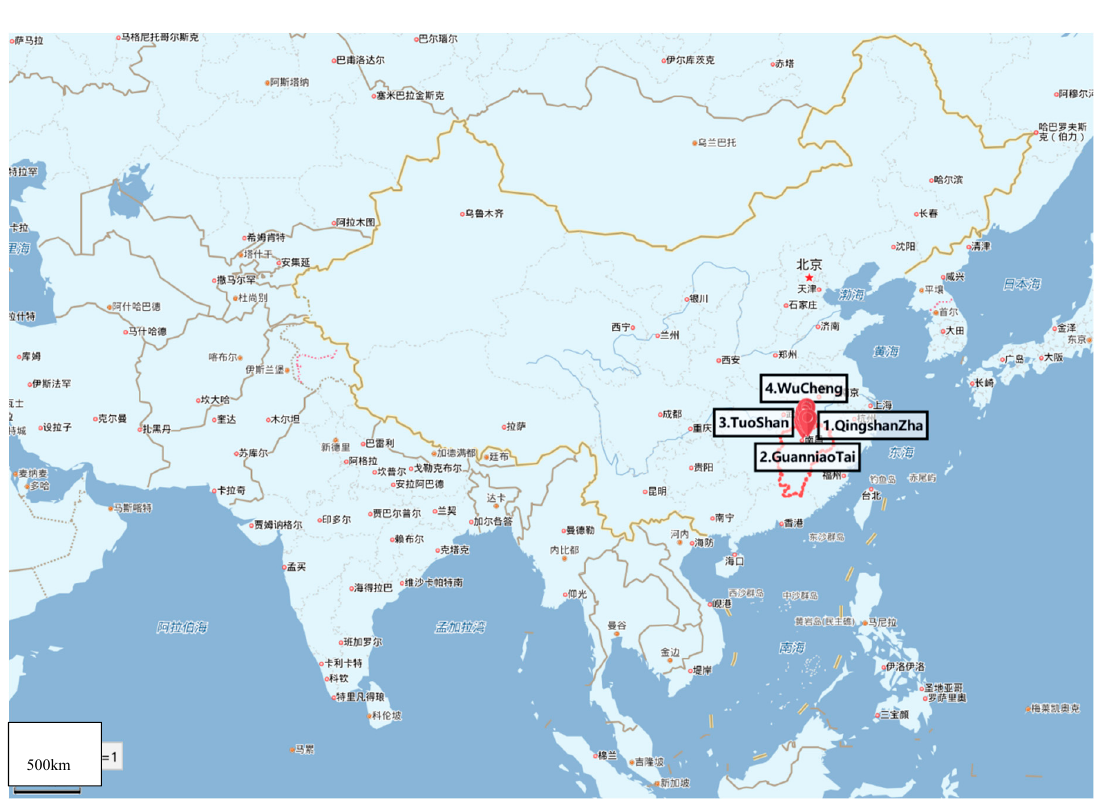
Figure 1. Distribution of sampling sites in China.